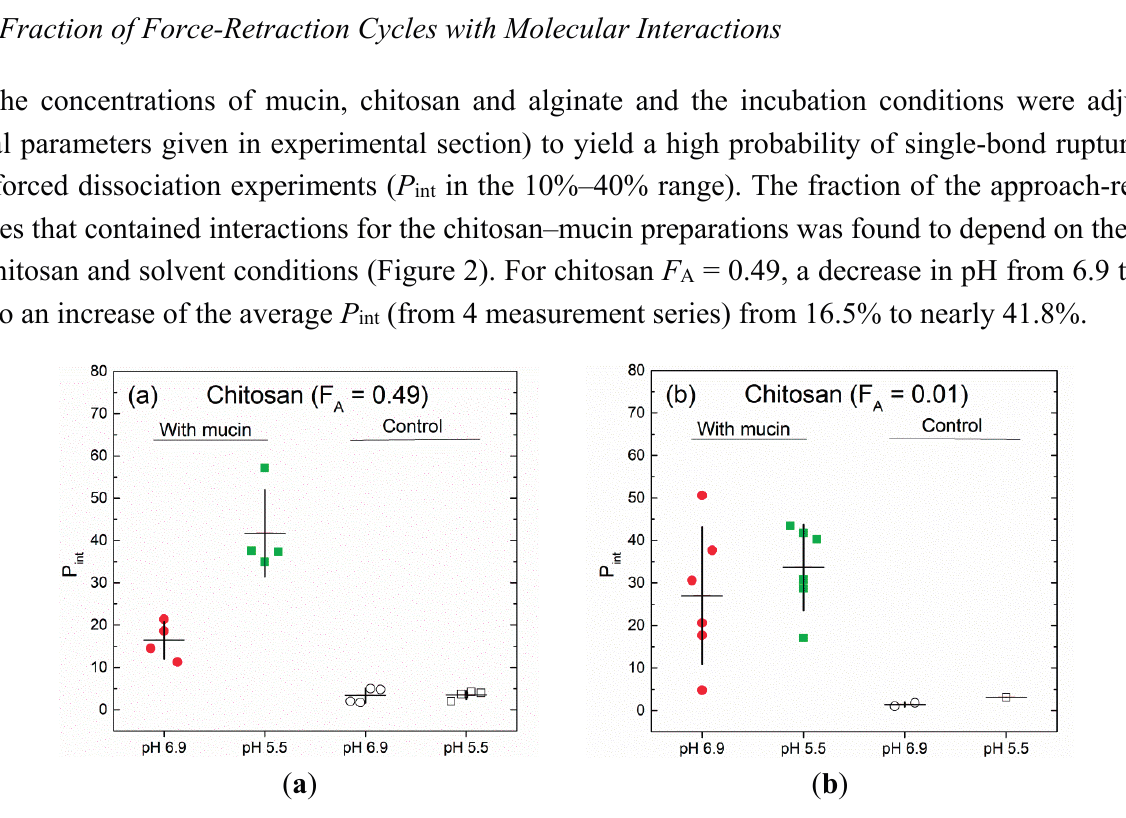
Figure 2. The fractions of mucin–chitosan force-distance curve cycles containing unbinding events. AFM tips functionalized with chitosan with acetyl content in two groups, ( a ) F A = 0.49 and ( b ) F A = 0.01 were used to repeatedly probe pig gastric mucin immobilized on mica (filled symbols) or aminosilanized mica (labeled as control, open symbols) at pH 6.9 (25 mM Hepes buffer, 150 mM NaCl, circular symbols) and after changing the pH to 5.5 (25 mM acetate buffer, 150 mM NaCl square